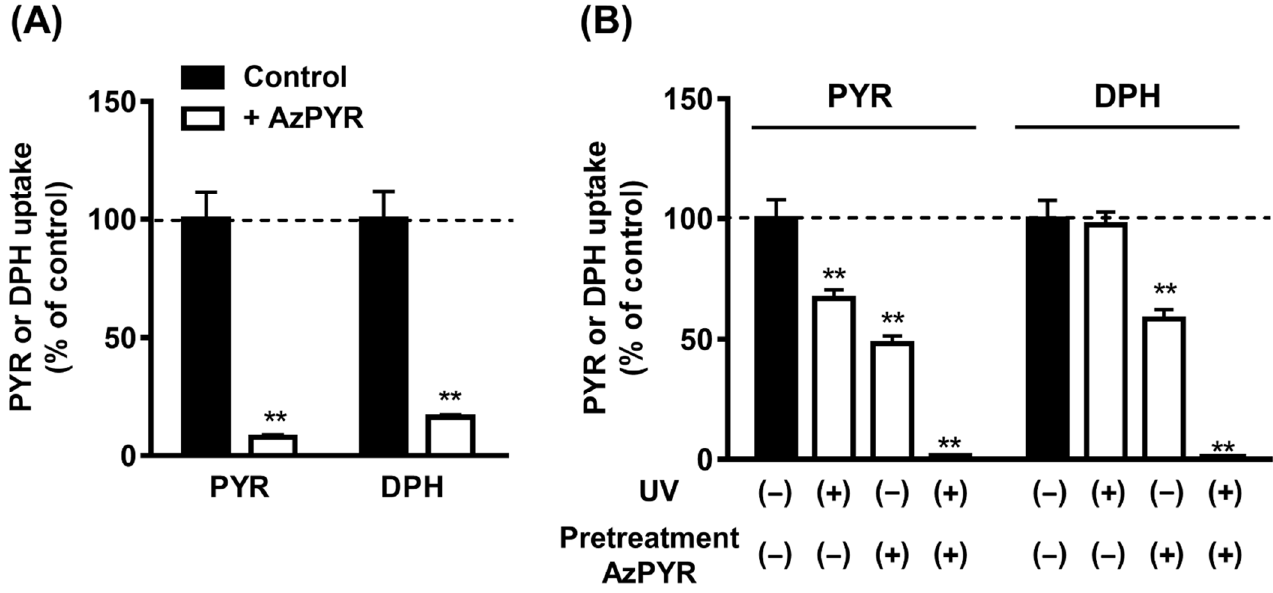
Figure 2. ( A ) Inhibitory effect of AzPYR on H + /OC antiporter-mediated uptake. The uptakes of PYR and DPH by hCMEC/D3 cells were measured in presence or absence of AzPYR at 0.4 mM under room light. ( B ) Effect of photo-cross-linking reaction on H + /OC antiporter activity. hCMEC/D3 cells were pretreated in the buffer with or without AzPYR under UV light or room light for 5 min at 37 °C. The treated cells were washed and further incubated in buffer to remove the unreacted AzPYR, and then the uptakes of PYR and DPH were measured. Each point represents the mean ± standard error ( n = 3–4). ** p < 0.01 compared to the corresponding control uptake or non-treatment uptake. Significant difference in Figure 2A was examined with t -test.